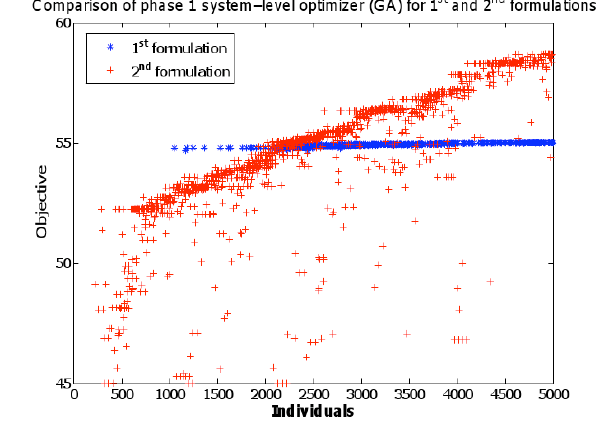
Fig. 9. Phase I optimization with first and second formula- tions (feasible